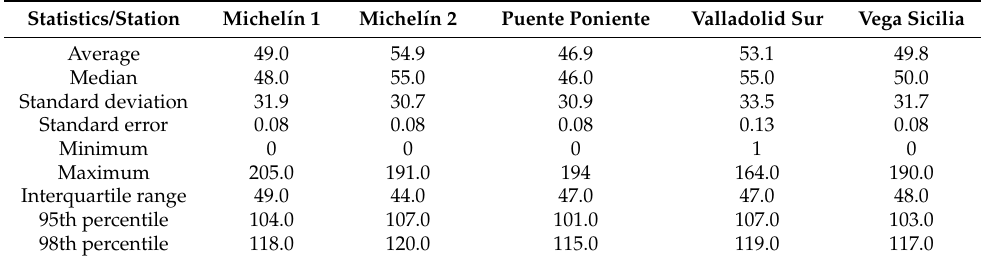
Table 2. Main statistics of ozone concentrations ( µ g m − 3 ) at the different monitoring